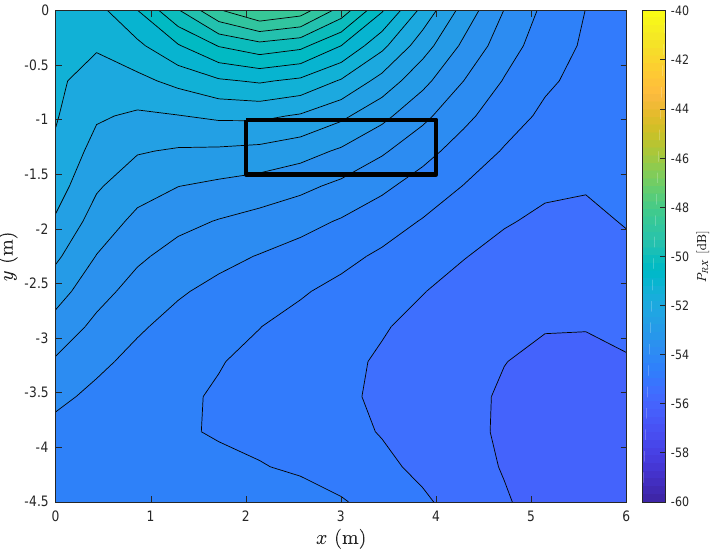
Figure 6. Contour of received power along the room considering a SISO system without the line-of-sight (LoS)